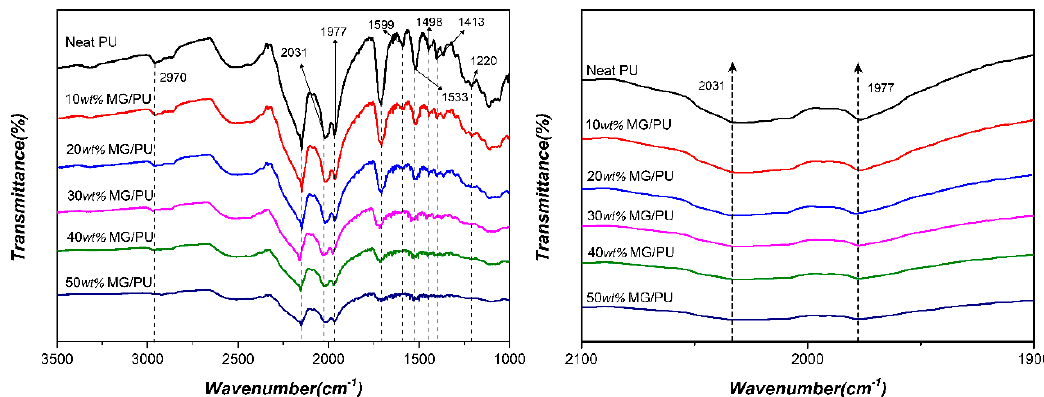
Figure 4. Left: FTIR spectra of MG/PU composite films with different weight fractions of graphite fillers. Right : Spectra scaled in the absorbance region of the carbonyl groups.